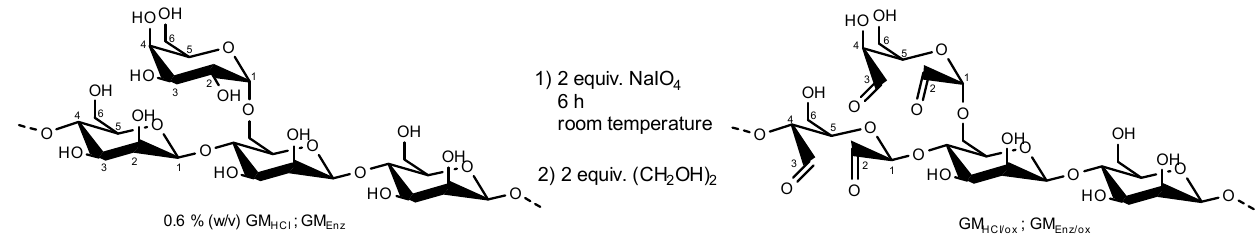
Figure 2. Oxidation reaction of acid and enzymatically hydrolyzed galactomannans by 2 equiv. sodium (meta)periodate (stochiometry on the basis of polymer chains). The structure of the fibers is only partially represented and only very few oxidations per polymer chain occurred.